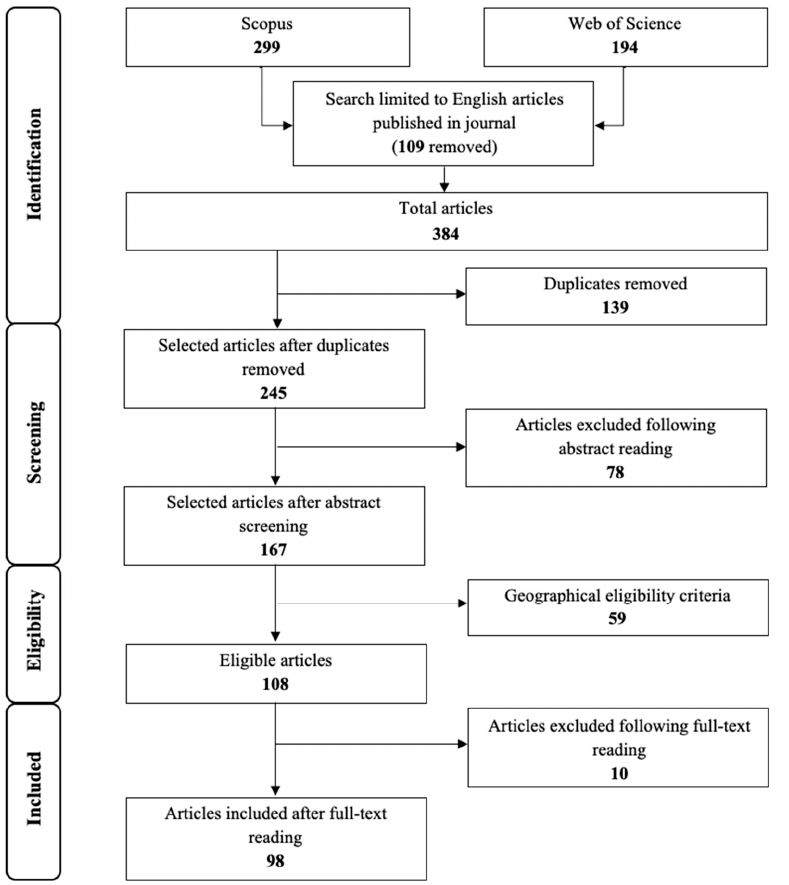
Figure 1. PRISMA flow diagram for the article selection process (numbers in bold indicate the number of papers for each stage of the systematic review). Table 2. Eligibility criteria.